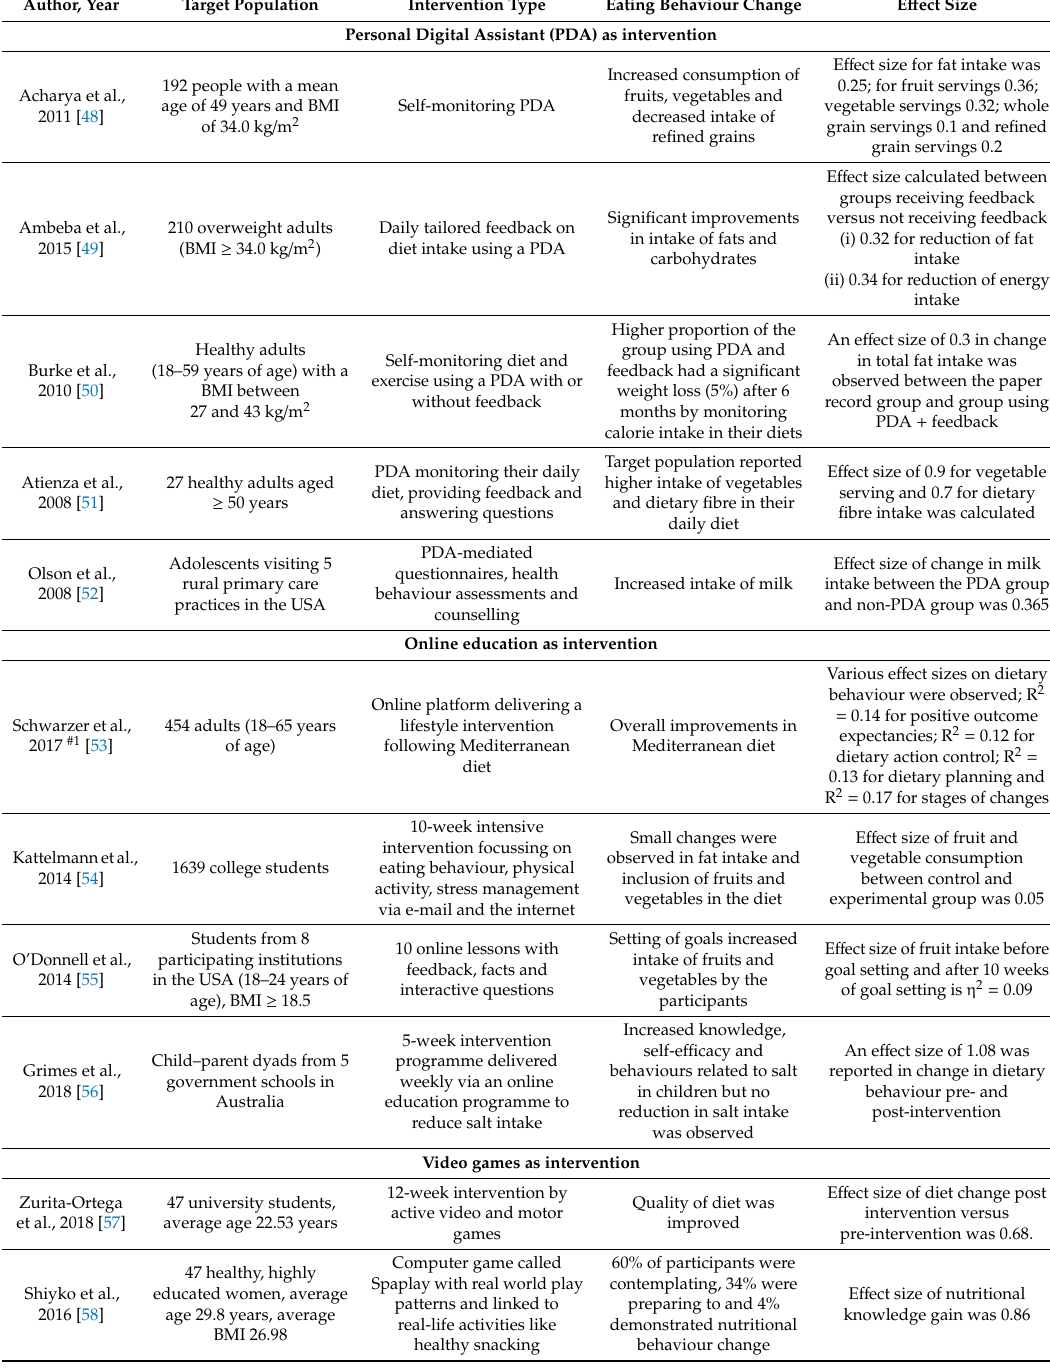
Table 1. Characteristics of the articles selected for